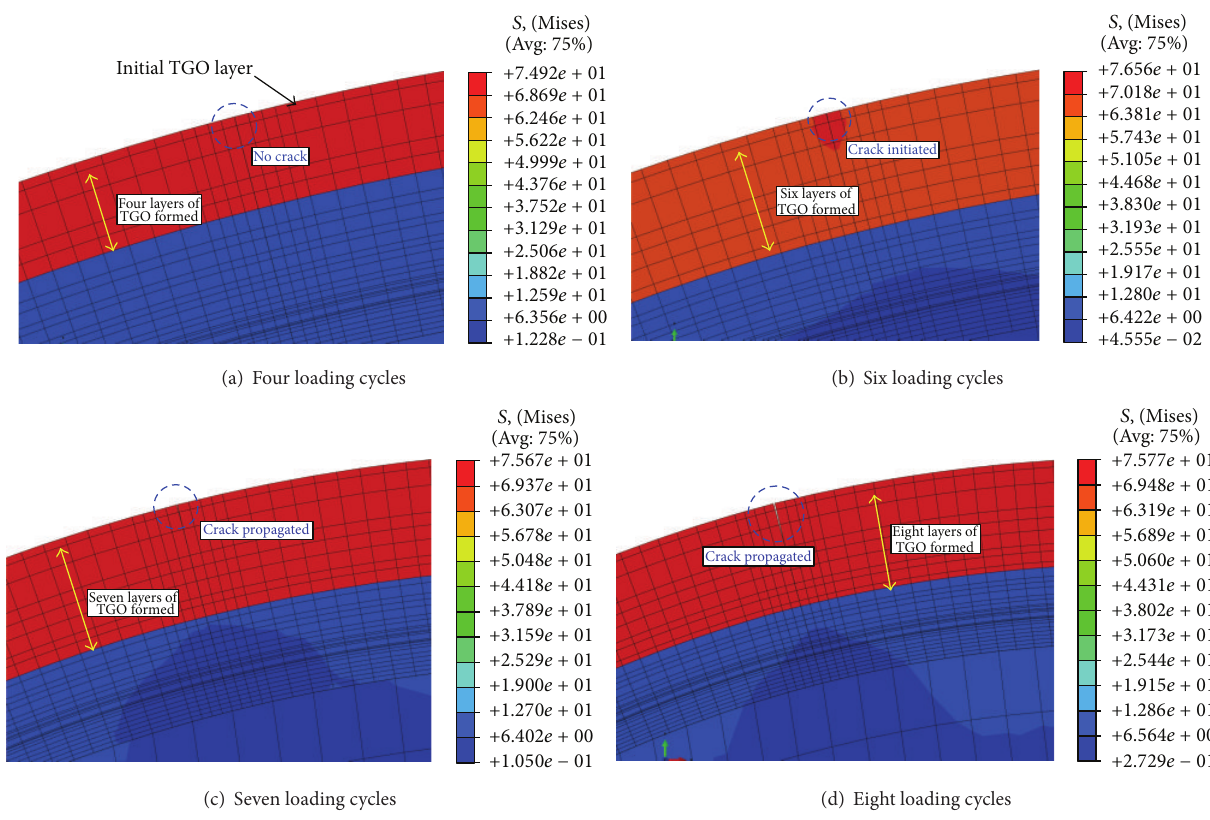
Figure 11: TGO growth upon cycles with TGO crack propagation: (a) 4 loading cycles, (b) 6 loading cycles, (c) 7 loading cycles, and (d) 8 loading cycles.